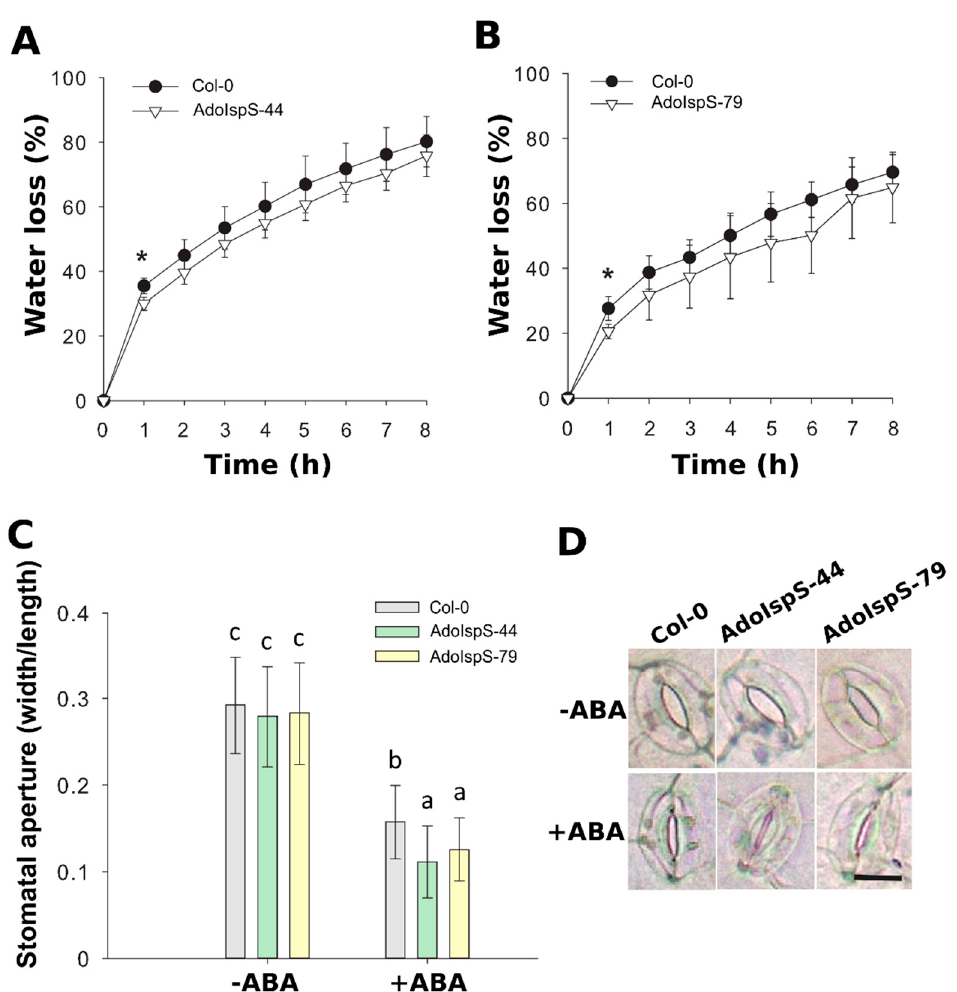
Figure 6. Water loss and stomatal aperture of Arabidopsis plants overexpressing IspS. ( A , B ) Water loss from the leaves of Col-0 and transgenic plants at various time-points after leaf detachment. Asterisks indicate significant differences between Col-0 and the transgenic lines ( t -test, p < 0.05). Line bars report the standard deviation of the mean. ( C ) Stomatal apertures in Col-0 and IspS transgenic plants treated with ABA. Histogram bars marked with the same letter do not significantly differ from each other (Tukey–Kramer test, p > 0.05). Line bars represent the SD of the means. ( D ) Representative images of stomata from the different genotypes before and after ABA treatment. Scale bar = 10 μ m.